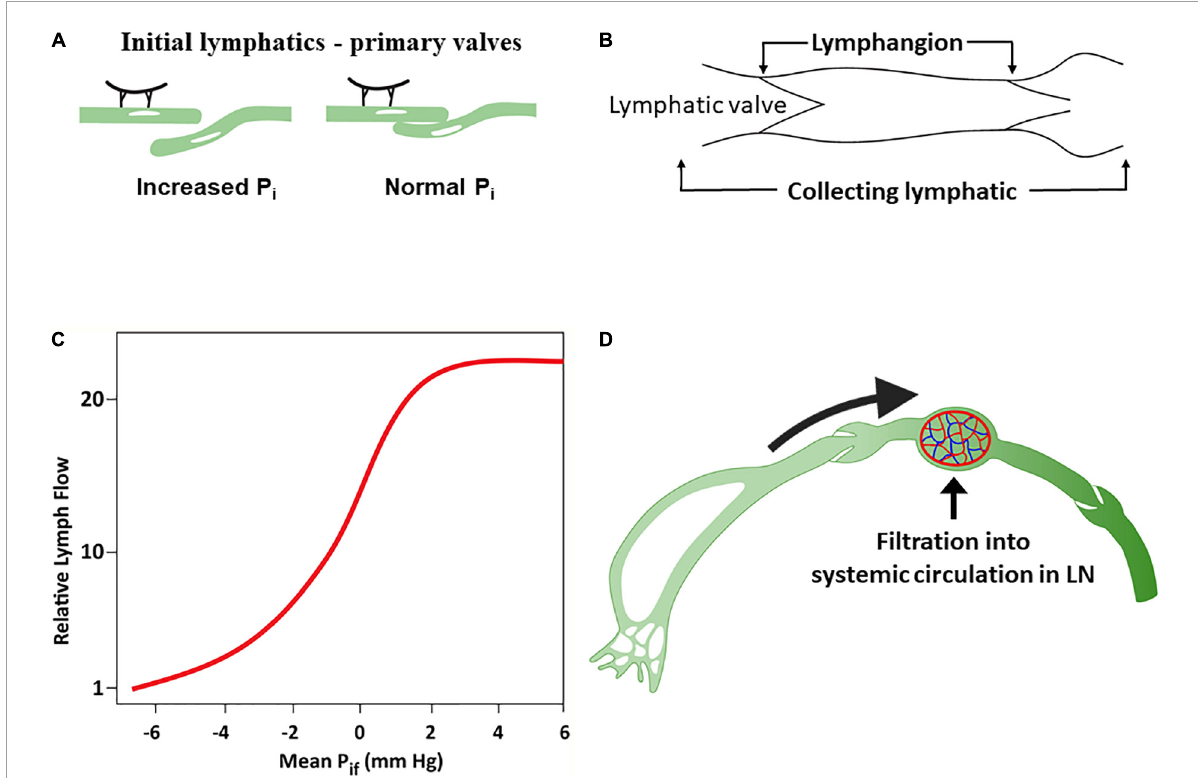
FIGURE3 The lymphatic system. (A) Response of lymphatic capillaries to an increase in interstitial fluid volume. As the tissue matrix expands, tension on the anchoring filament rises, and the lymph capillaries open to allow entry of interstitial fluid into the initial lymphatics. (B) A lymphangion is defined as the segment between two unidirectional valves and typically exhibits systole and diastole. (C) Relationship between interstitial fluid pressure and lymph flow (D) . Under normal conditions, a substantial amount of lymph is reabsorbed in the nodal blood circulation depending on hydrostatic and osmotic forces acting at the blood–lymph barrier. Modified from references (58,